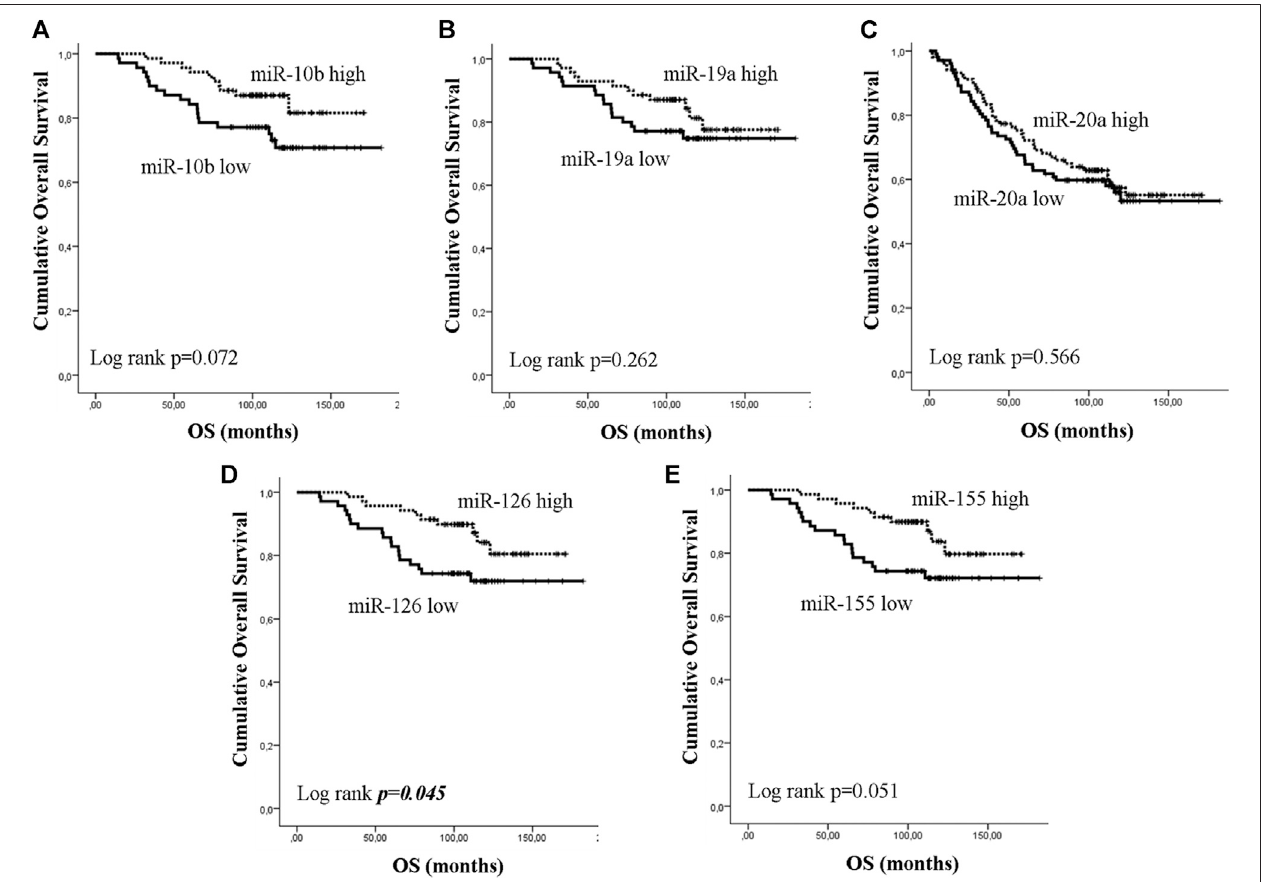
FIGURE 4 | Kaplan – Meier analysis for overall survival (OS) according to the expression of circulating miRNAs. Patients were classi fi ed as high or low expression groups based on the median value of each miRNA expression. OS in patients with high or low (A) miR-10b, (B) miR-19a, (C) miR-20a, (D) miR-126 and (E) miR-155. Curves were compared using the log rank test. P values are